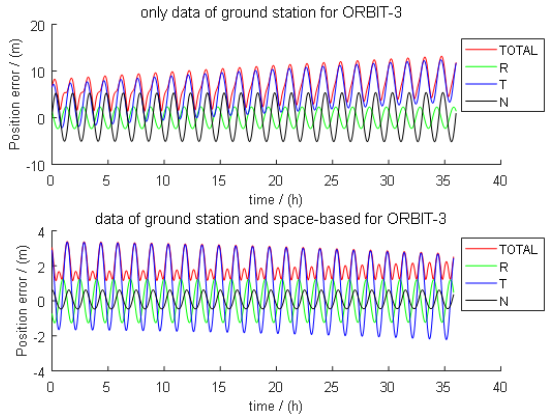
Figure 5. Effects of space-based angle data on the accuracy of